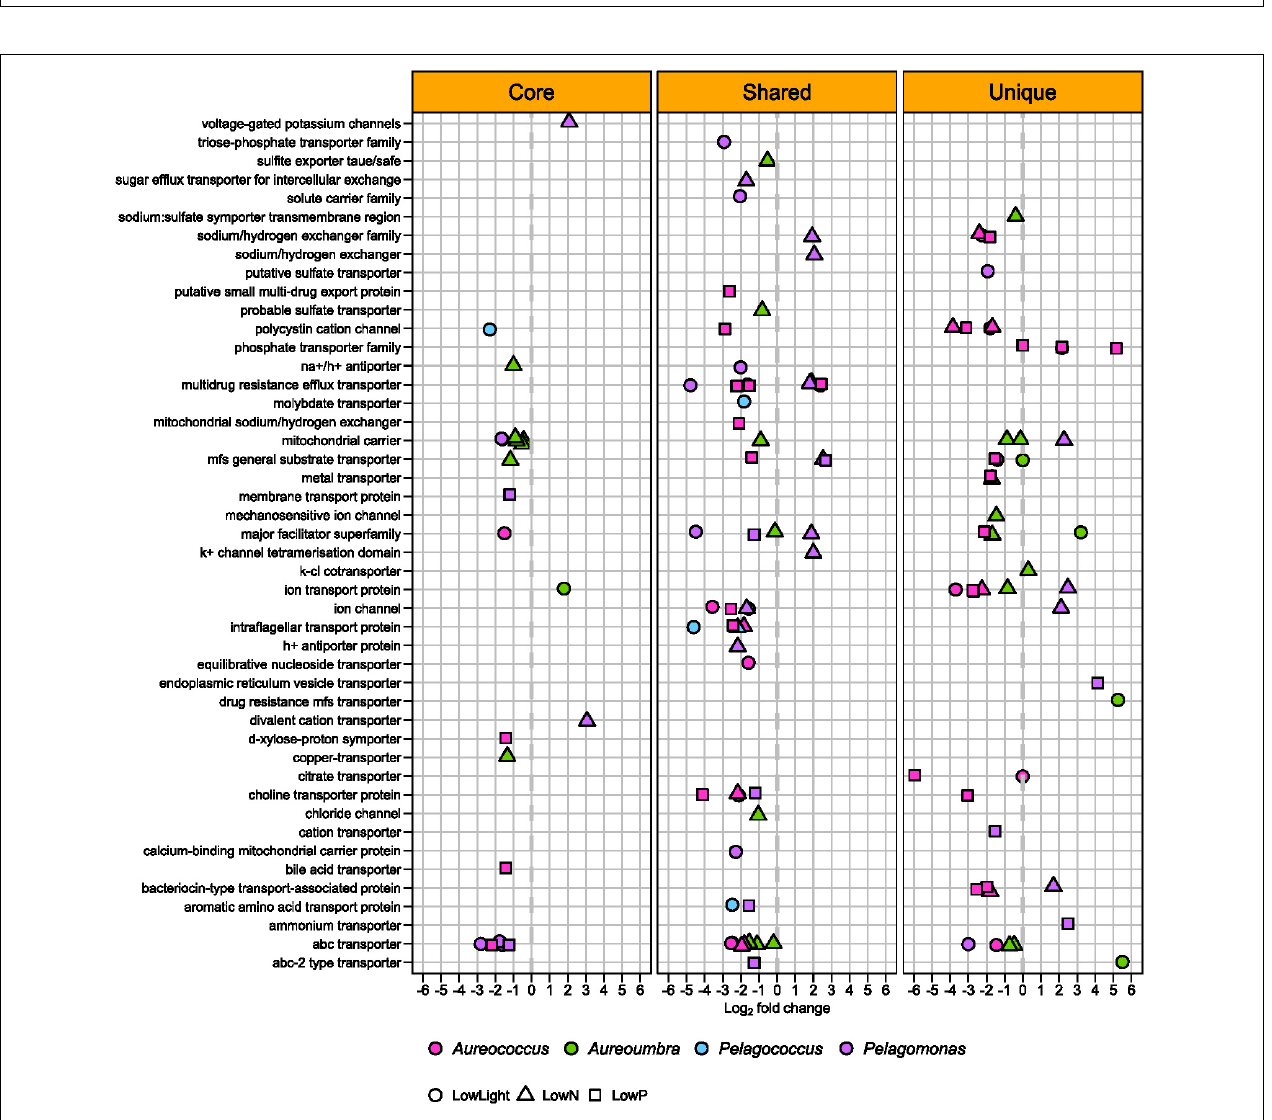
FIGURE 8 | Differentially abundant OGs associated with transport among four pelagophytes across treatments relative to the control.